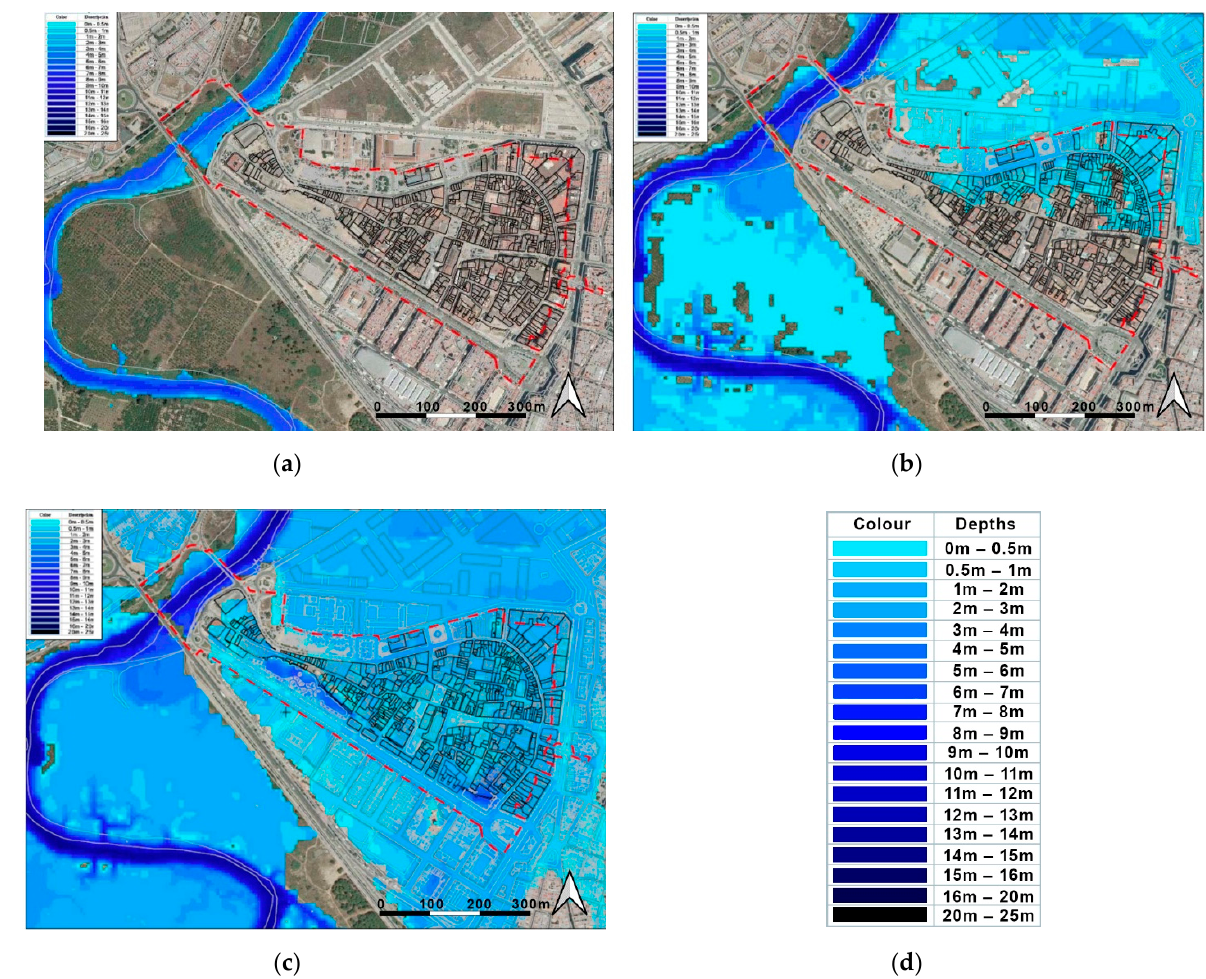
Figure 4. ( a ) Water depths for the avenue over a period of 10 years. ( b ) Water depths for the avenue over a period of 100 years. ( c ) Water depths for the avenue over a period of 500 years. ( d ) Legend. Source: